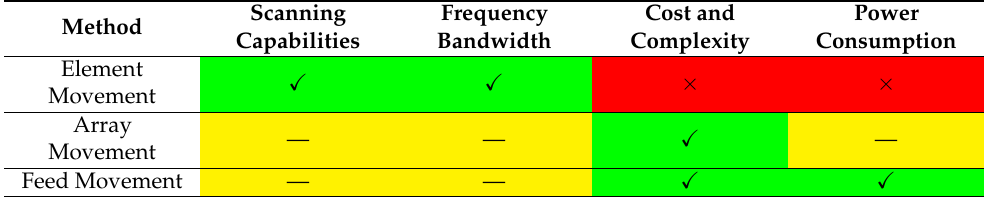
Table 4. Comparative analysis of reconfigurable approaches discussed in this